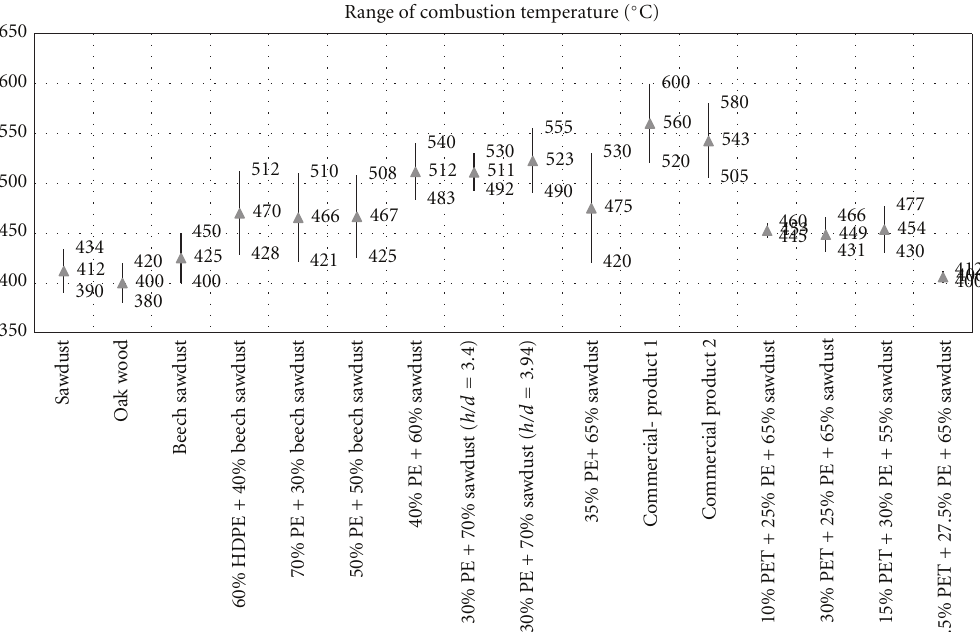
F 4: Range of combustion temperature in the open